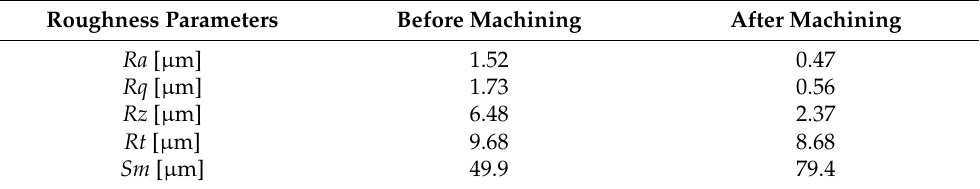
Table 8. Selected 2D roughness